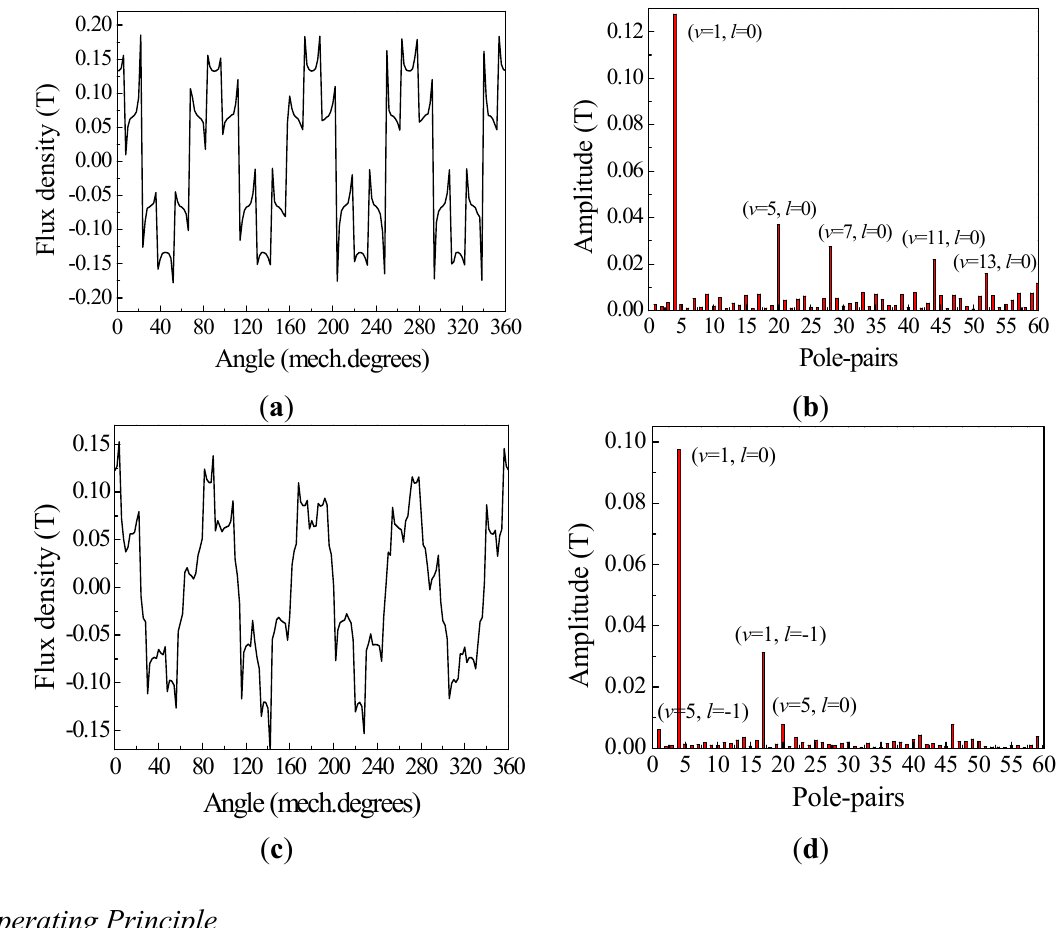
Figure 6. Axial flux density waveforms due to the stator winding, in the air gap adjacent to the permanent magnet rotor and corresponding space harmonic spectra: ( a ) axial flux density waveform without the modulating ring rotor; ( b ) the space harmonic spectrum without the modulating ring rotor; ( c ) axial flux density waveform with the modulating ring rotor; and ( d ) the space harmonic spectrum with the modulating ring rotor.